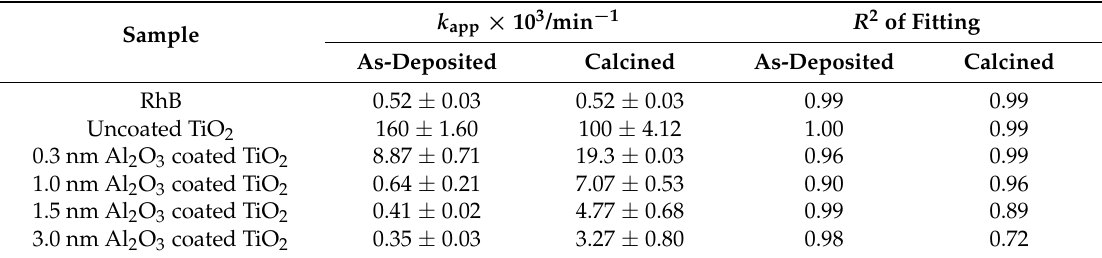
Table 1. Apparent first-order rate constant, k app , of anatase TiO 2 powders coated with Al 2 O 3 with different film thicknesses.